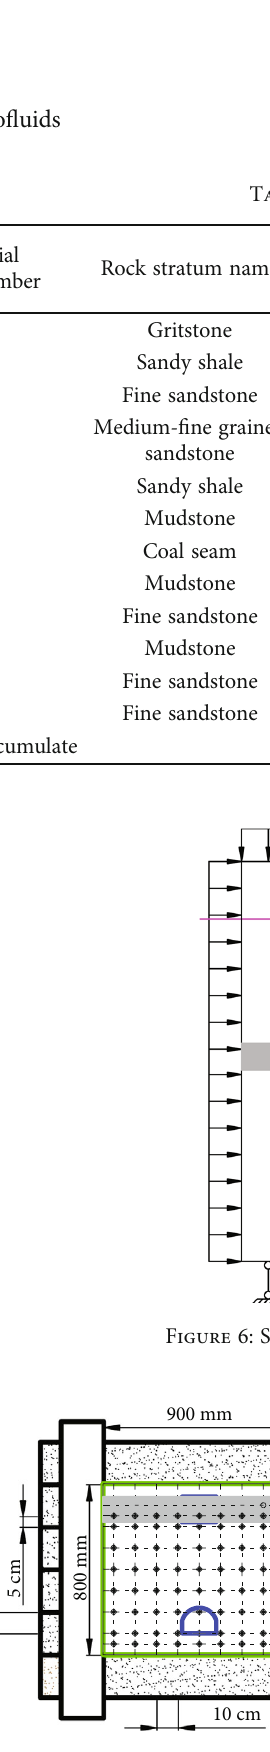
Figure 7: Displacement measuring line and monitoring point layout plan of viewing window.